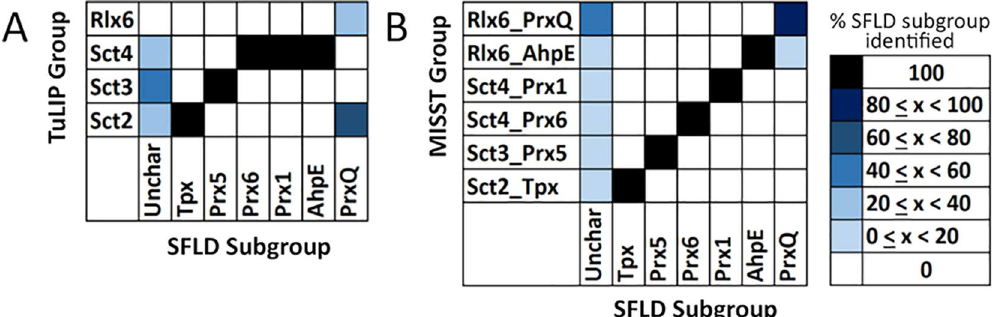
Fig 3. TuLIP- and MISST-identified groups correspond well with expertly-identified subgroups. TuLIP (A) and MISST (B) groupsare shown on the y-axis and comparedto the six known subgroupson the x-axis. Grid fill color denotesthe percent of protein structures (A) or sequences(B) in each SFLD subgroup identifiedby each TuLIP (A) or MISST (B) group, accordingto the legend.The MISST heat map containsall sequencesidentified with a DASP2 search score (cid:20)